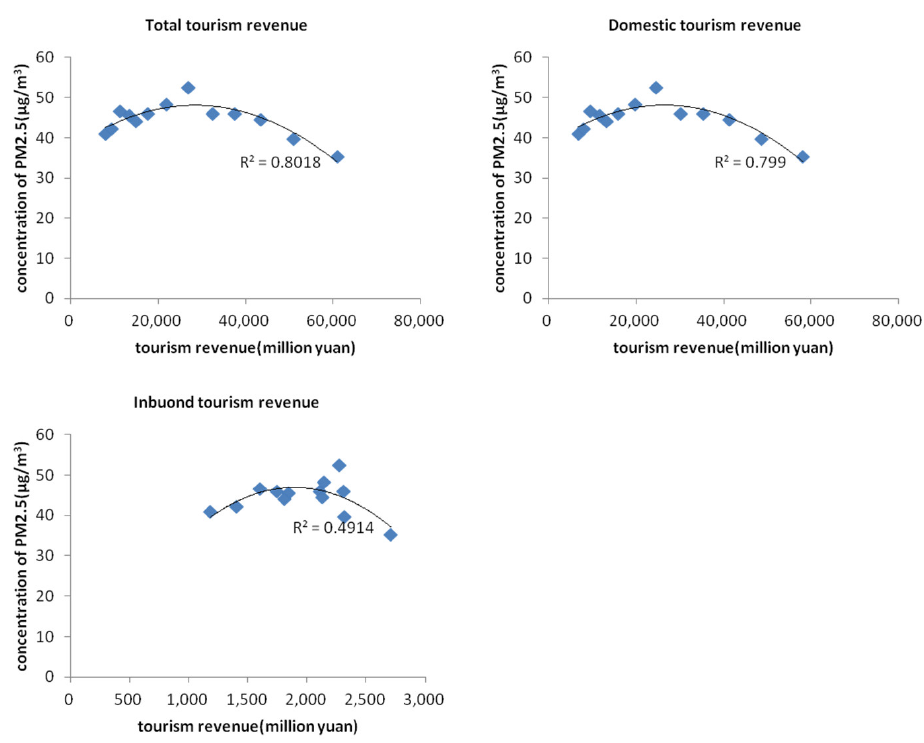
Figure 1. Scatter diagram of total/domestic/inbound tourism revenue and PM 2.5 concentration.